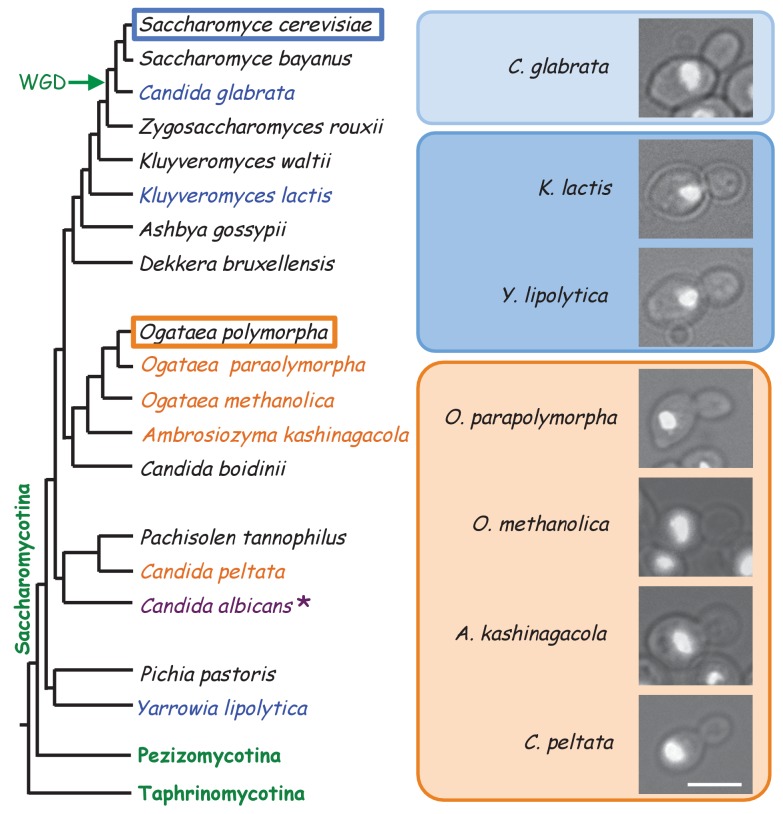
Nuclear position in different yeasts and their phylogenetic relationship.The Phylogenetic tree is based on Kurtzman et al., 2011 and is not drawn to scale. Different yeast strains growing in YPDS at 30°C were fixed with ethanol and DNA was visualized with DAPI. Yeast strains used were BY21165, BY21167, BY23876, BY5243, JCM9829, JCM 10237, and JCM15019. * the regulation of nuclear position is reported not as strict as that in S. cerevisiae (Martin et al., 2004; Finley et al., 2008).